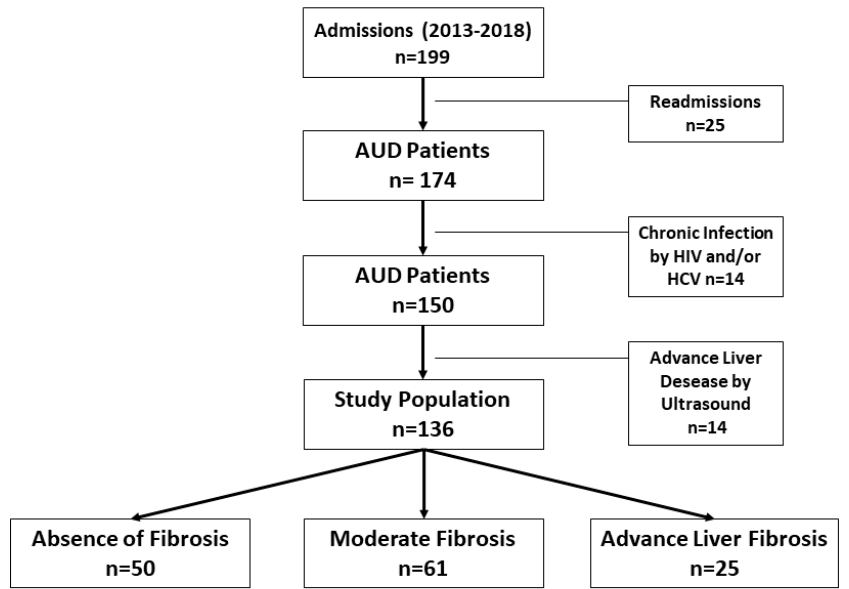
Figure 1. Selection of patients, exclusion criteria, and study groups according to degree of liver fibrosis (LF). AUD, alcohol use disorder; HCV, hepatitis C virus; HIV, human immunodeficiency vi- rus.